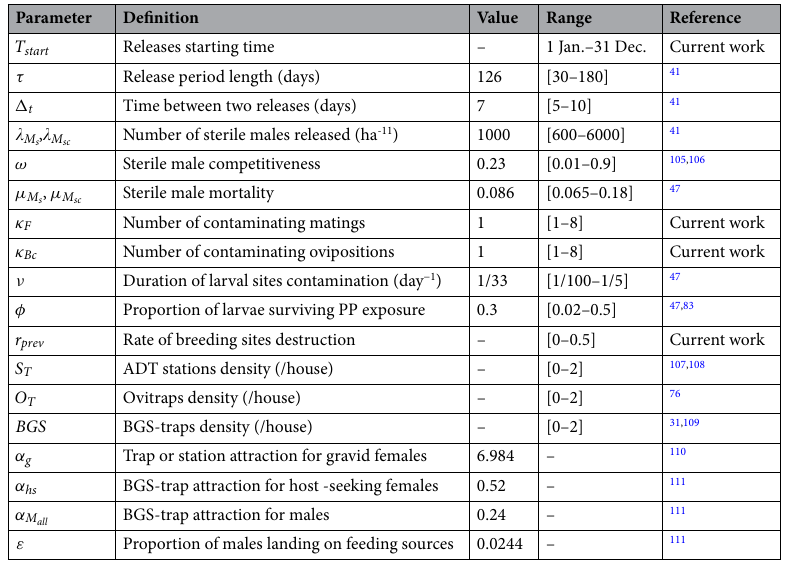
Table 1. Parameters values of vector control methods for tropical and temperate